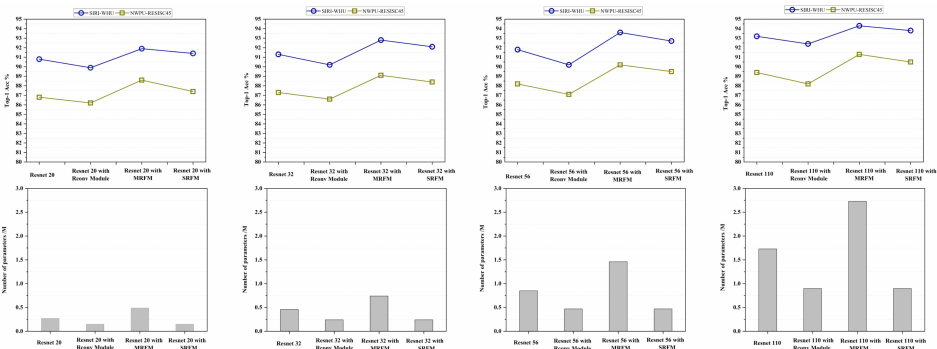
Figure 3. In order to investigate the impact of each component in the redundancy mapping module on the CKD framework, we compared the performance of a series of student sub-networks (Resnet20, Resnet32, Resnet56, and Resnet110) of different depths and the corresponding